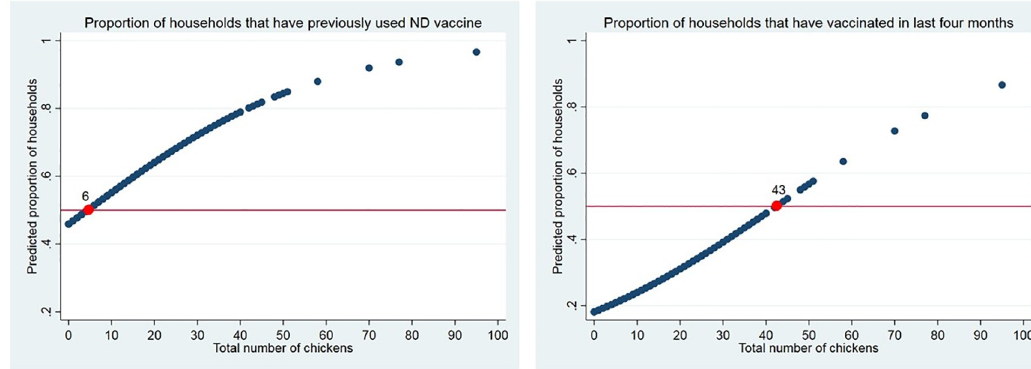
Fig 3. ND vaccine adoption by flock size. Predicted proportions of households that have previously vaccinated versus vaccinated recently (within 4 months) as a function of flock size.